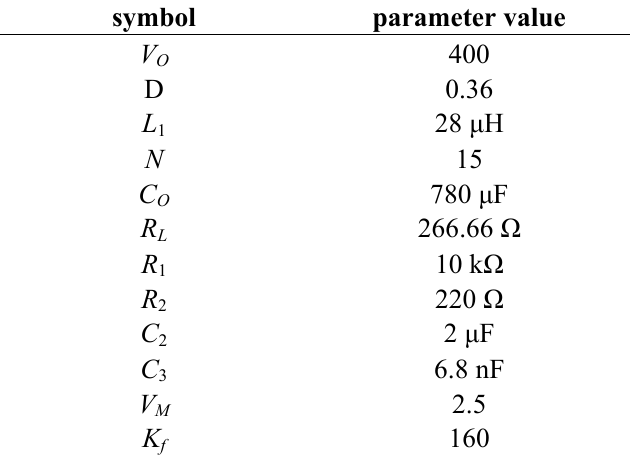
Table 1. Parameter values of small signal model of the proposed converter.